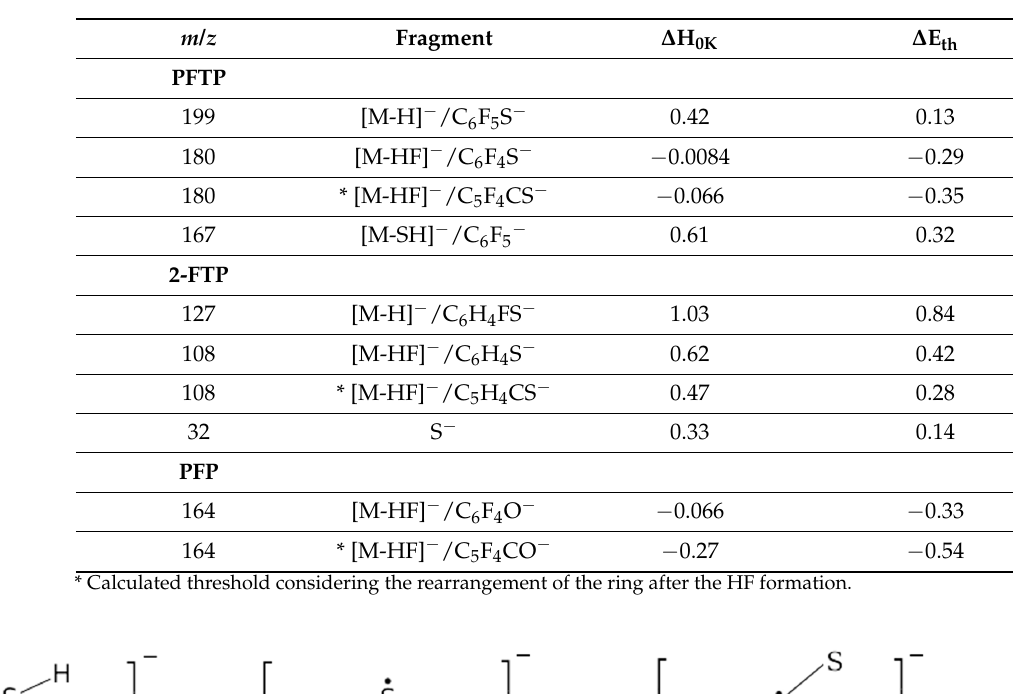
Table 1. Calculated 0K reaction enthalpies ( ∆ H 0K ) and thermally corrected thresholds ( ∆ E th ) for the fragments observed in DEA to PFTP and 2-FTP. For the HF loss, the values are shown for both the direct process, [M-HF] − /C 6 F 4 S − or C 6 H 4 S − and for the rearrangement process shown in Figure 2, formation upon DEA to PFP. The calculations are performed at the B3LYP D3BJ/aug-cc-pVTZ level of theory.